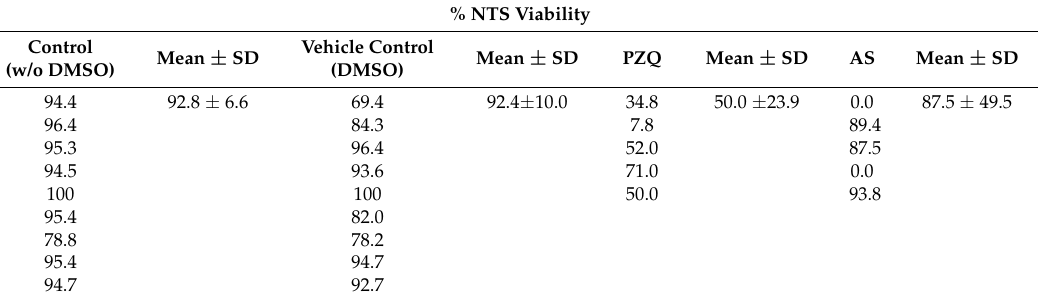
Table 2. Viability of NTS of S. mansoni (mean ± SD) at 72 h of exposure in vitro to praziquantel (PZQ), artesunate (AS), or DMSO (vehicle) at 100 µ